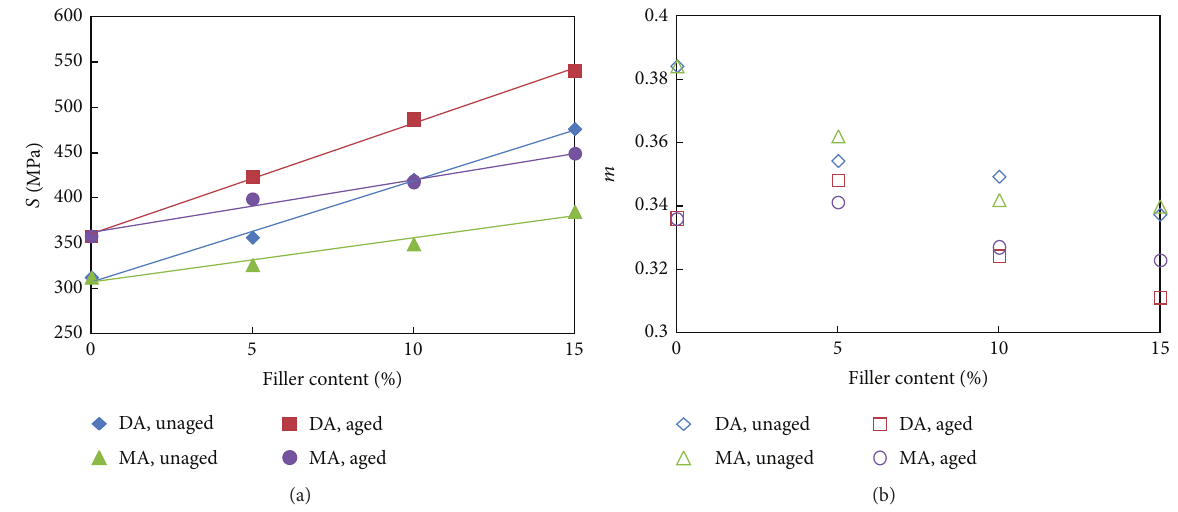
Figure 10: Results of BBR test before and after TFOT. (a) Creep stiffness ( 𝑆 ). (b) Creep rate ( 𝑚 ).